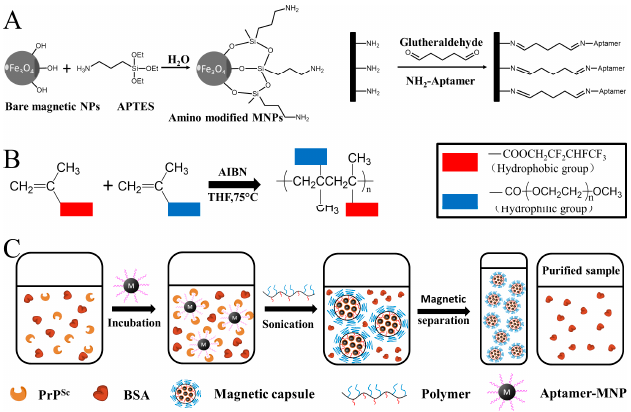
Figure 1. The schematic representation of ( A ) the synthesis processes of AMNPs, ( B ) the synthesis processes of amphiphilic copolymer, and ( C ) the capture, embedding and concentration processes of PrP Sc .